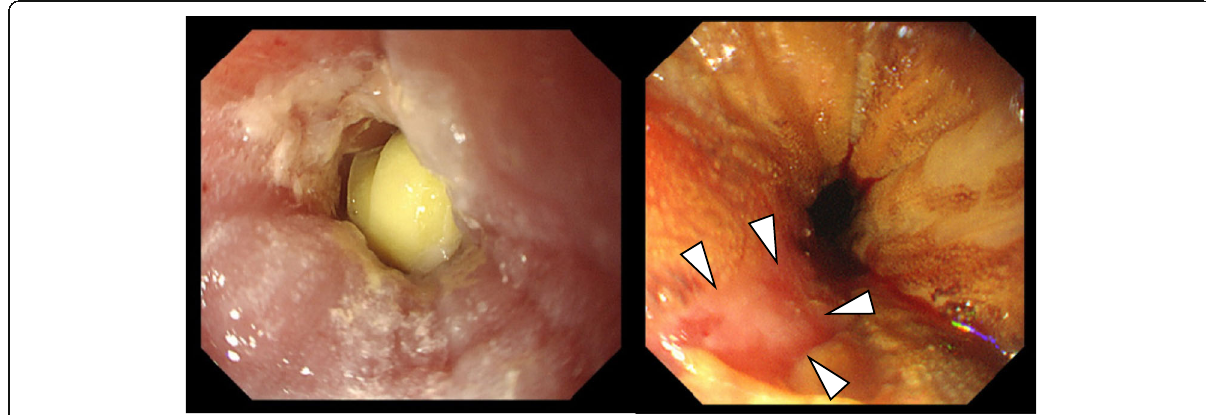
Fig. 1 Upper gastrointestinal tract endoscopic examination findings. a Circumferential stenosis and lumen occluded by a tablet 30 cm from incisors are visible. b A 2-cm of band unstained by Lugol ’ s solution (arrows) was